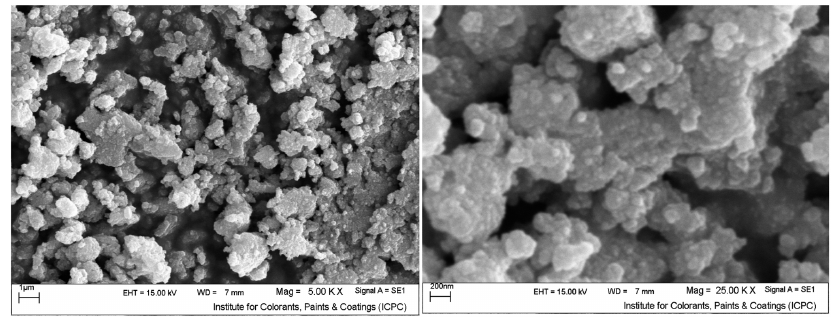
Figure 2: SEM image of CdS nanoparticles.